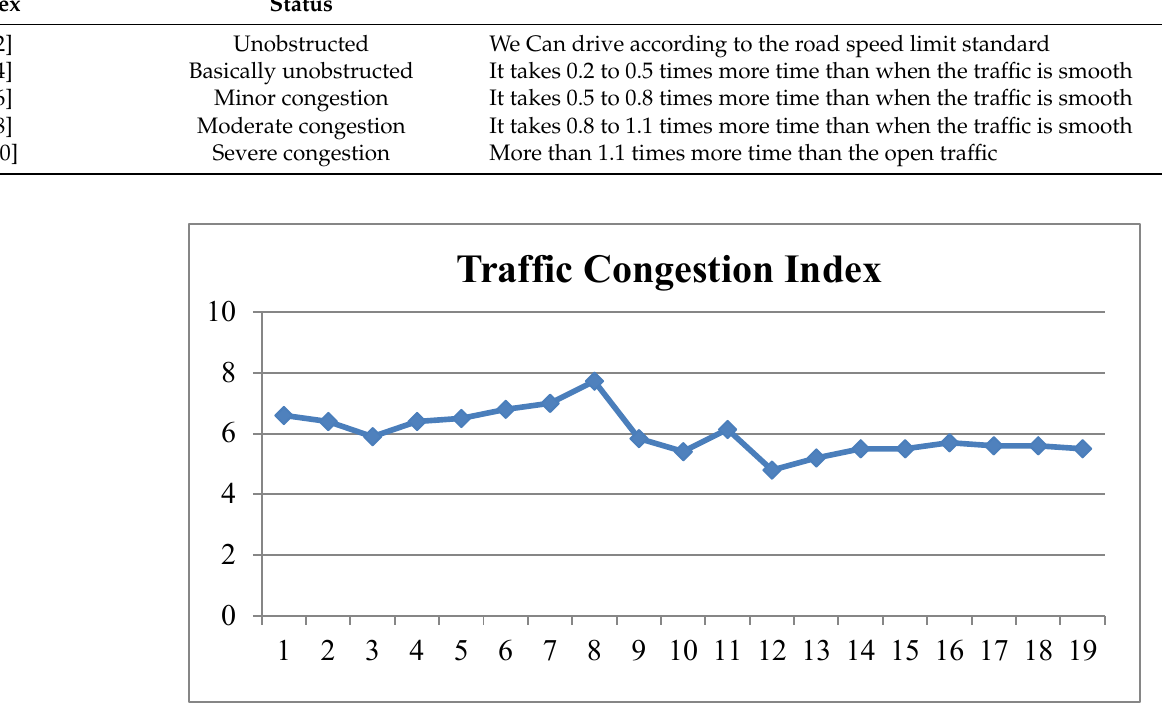
Figure 3. The volatility of traffic congestion index.